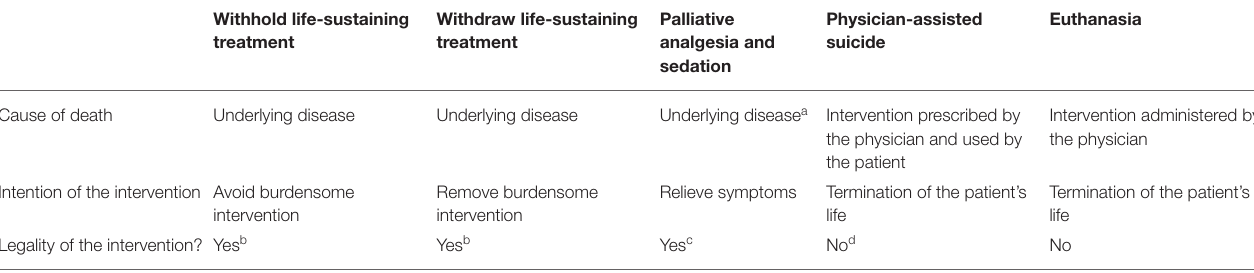
TABLE 2 | End of life interventions, causes of death, clinicians’ intention of the interventions, and legality of the interventions in the U.S. From Olsen et al.